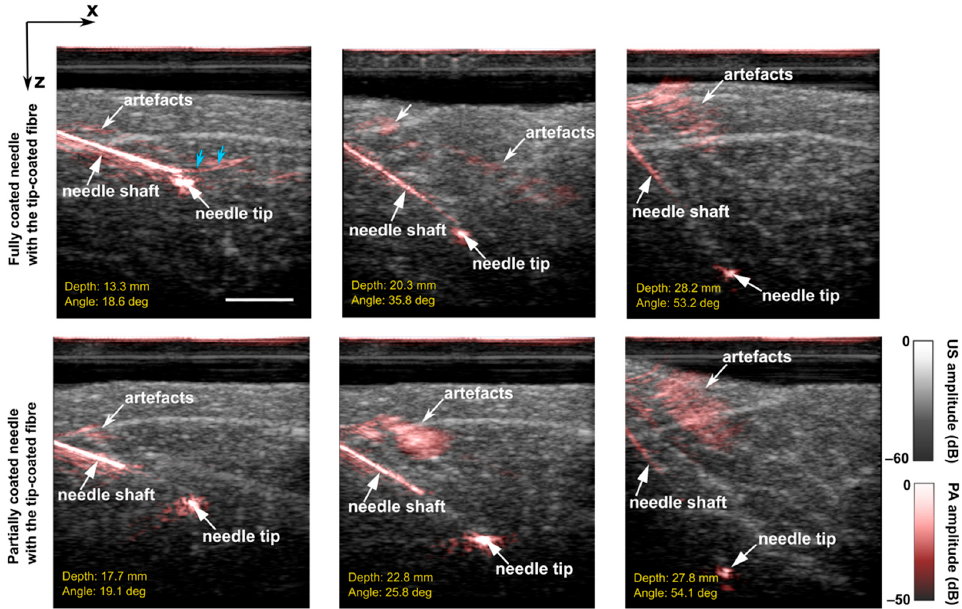
Figure 6. Overlaid Photoacoustic (PA) and Ultrasound (US) images acquired during in-plane needle insertions into a pork joint tissue ex vivo with a fully coated needle and a partially coated needle (tip-coated fibres inside the lumens). Blue arrows denote arc-shaped artefacts from the needle tip. Images were obtained from real-time reconstructions and displayed on a logarithmic scale. All the images have the same scale bar of 1 cm.